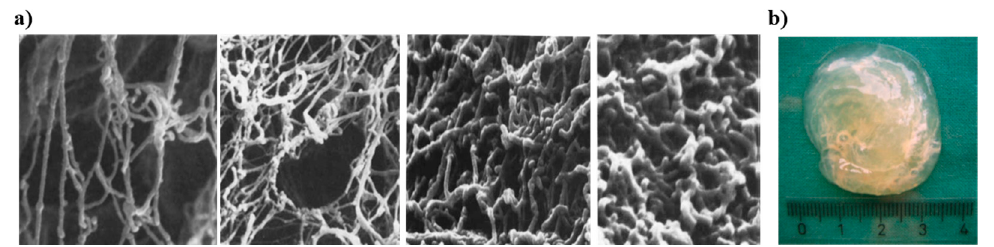
Figure 4. (Left) CMP at different stages of pregnancy ( a ) (left to right) at 20th day, 5 weeks, 2-1/2 months, and last week of pregnancy. Cervical mucin network density increases progressively during the gestation period, and forms a more compact interconnected fibrillar networks. The mucus functions as a selectively permeable plug that blocks pathogens and allows nutrients and growth factor to transport. Reprinted with permission from [80]. Copyright © 2011, John Wiley & Sons, Inc.; ( b ) Figure showing bulk structure of cervical mucus plug discharged during labor. Reprinted with permission from [77]. Copyright © 2010, John Wiley & Sons, Inc.